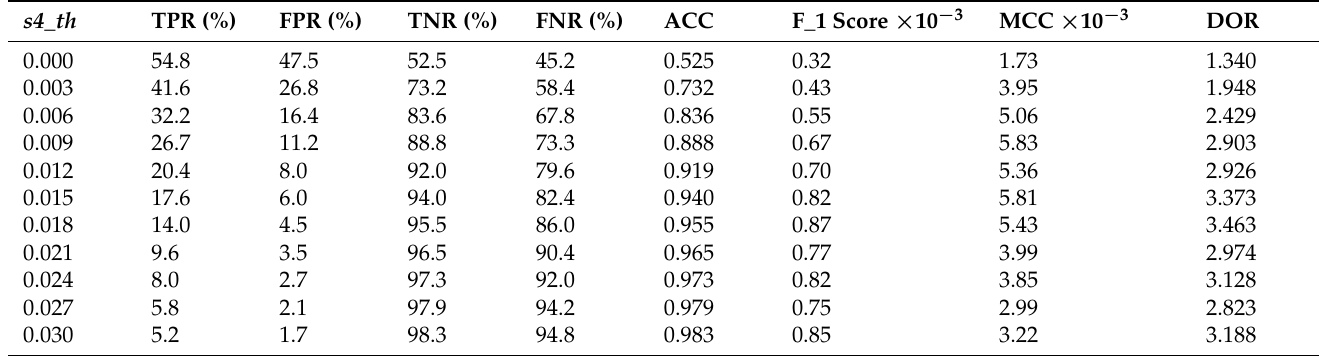
Table 4. Statistical measurements extracted from the previous confusion matrix, using the